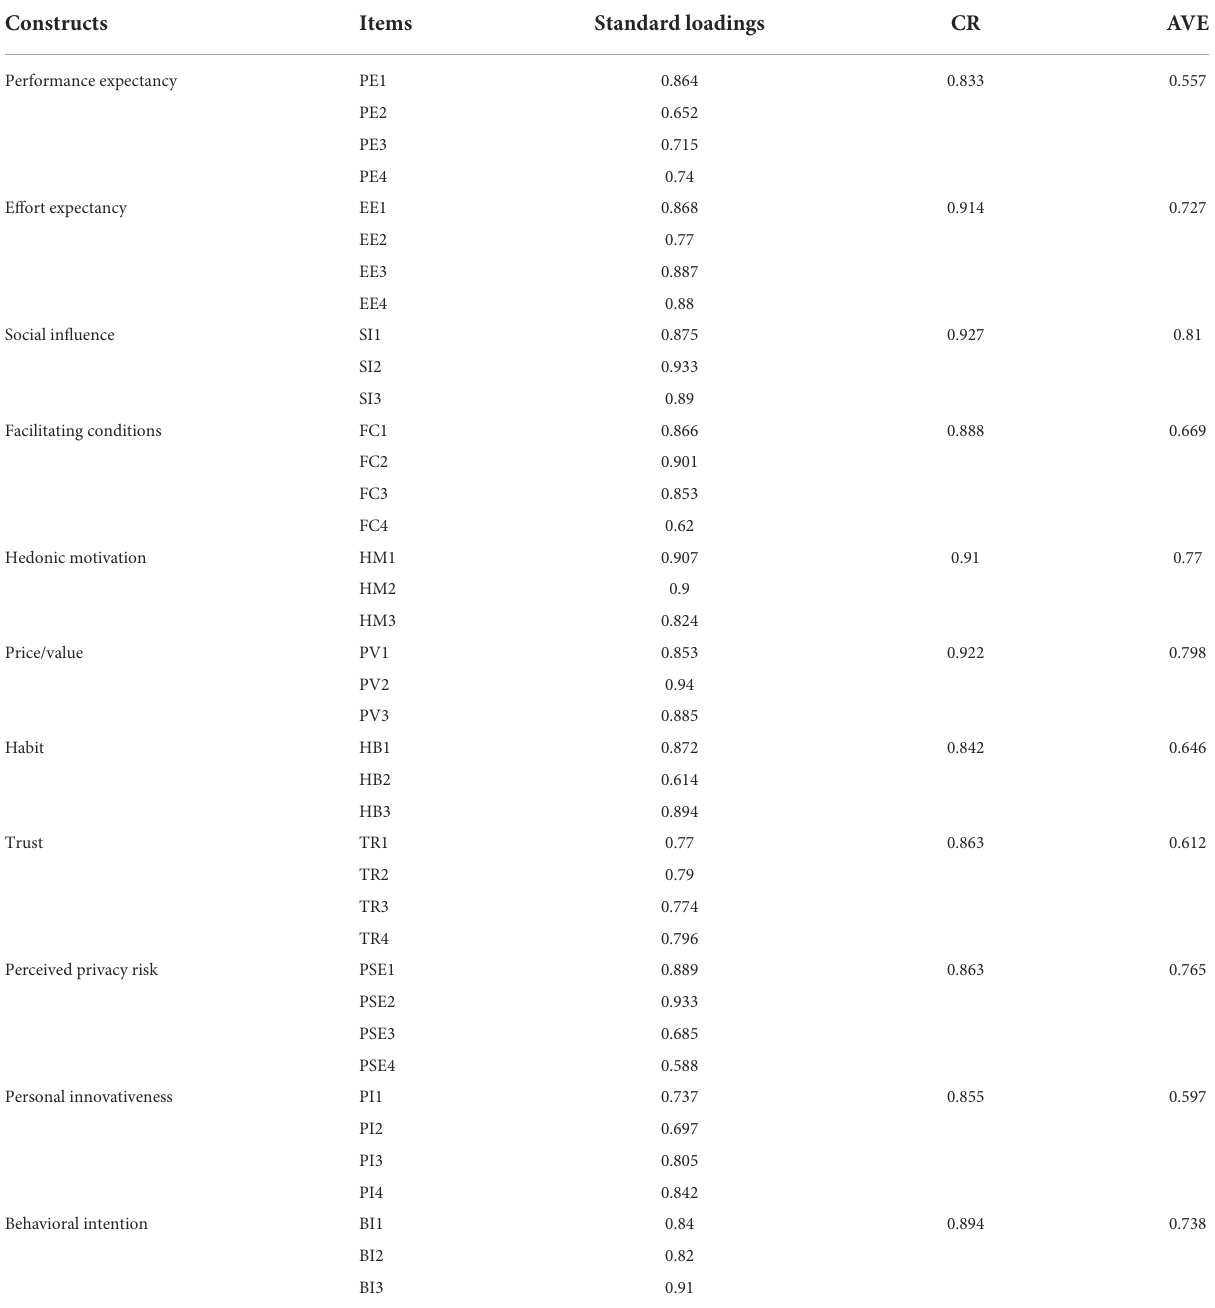
TABLE 5 Results for the measurement